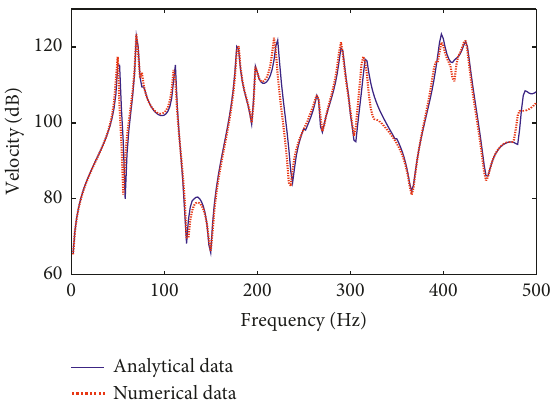
� 0.8m, 1 Figure 8: Vibration velocity response at the position ( x � 0.1m) on the surface of the stiffener. y 3